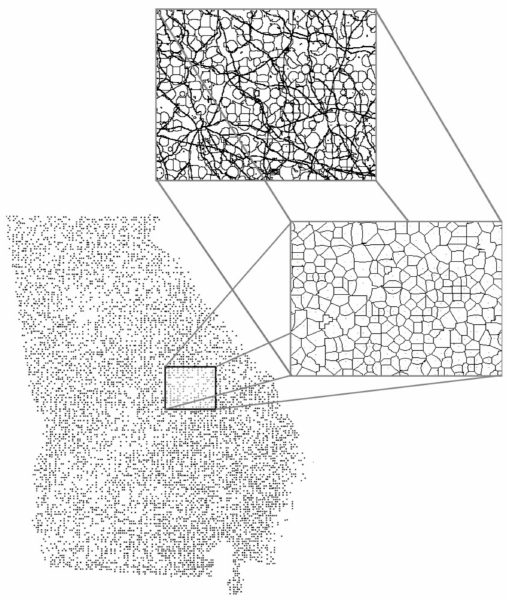
Figure 1. Spatial population of Forest Inventory and Analysis (FIA) data based on “growing circle”